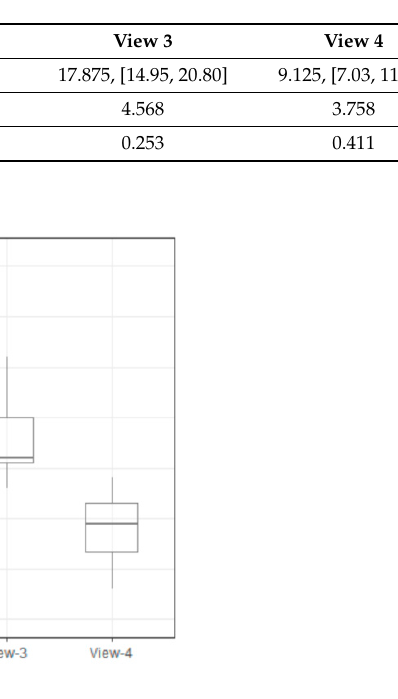
Figure 3. Number of insect visits to vegetation binned by each one-minute view for all observers . Note that view 1 had significantly less mean insect counts than all other views.